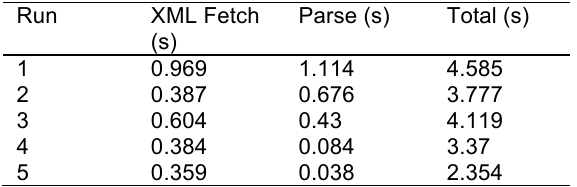
Table 3. The XML fetch and parse times in seconds over 5 runs for the data processing cloud service along with the total time.